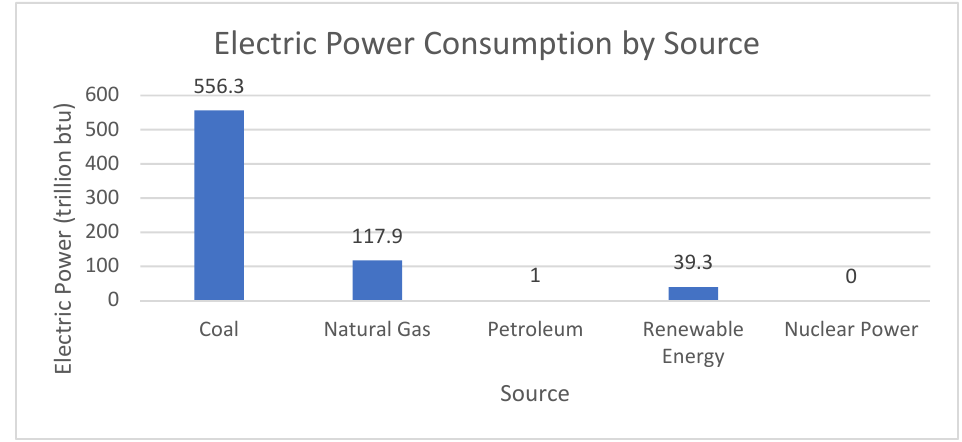
Figure 2. Electric power sector consumption by source for Kentucky [8].